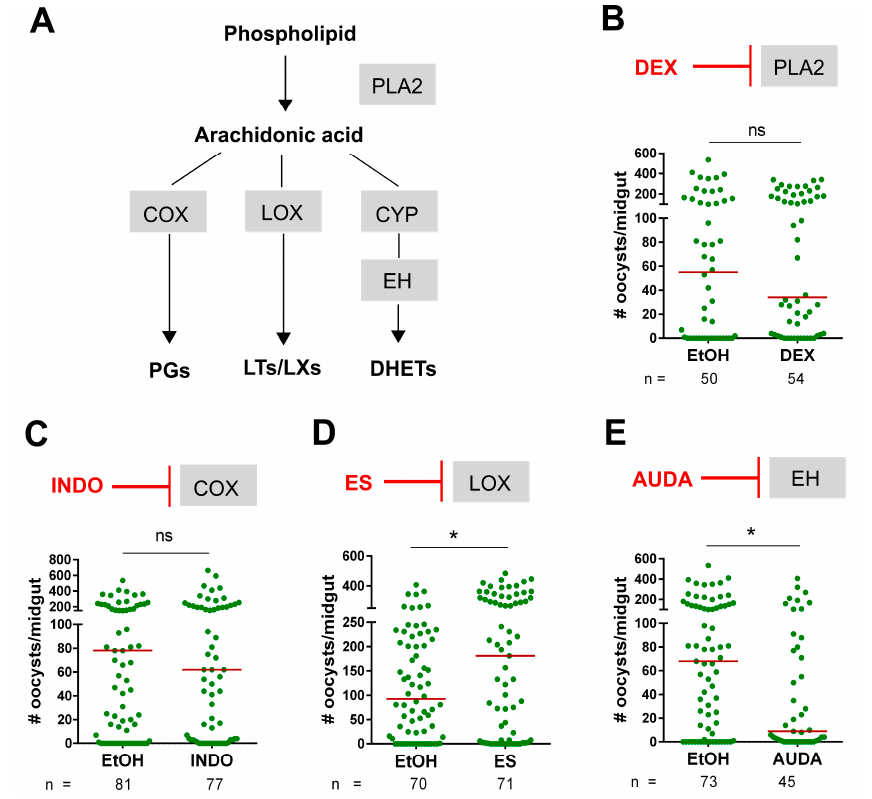
Figure 1. Effect of eicosanoid inhibitors on Plasmodium oocyst survival. Biosynthesis pathways of eicosanoids as described in mammalian systems are summarized in ( A ). Arachidonic acid (AA) is derived from membrane phospholipids by hydrolysis of phospholipase A2 (PLA2) activity. The AA is further metabolized into various eicosanoids, such as prostaglandins (PGs), leukotrienes (LTs), lipoxins (LXs) and dihydroxyeicosatrienoic acids (DHETs) through the activity of specific enzymes, cyclooxygenase (COX), lipoxygenase (LOX), cytochrome P450 (CYP), and epoxide hydrolase (EH), respectively. The influence of specific eicosanoid inhibitors on P. berghei survival was addressed in mosquitoes injected with each respective inhibitor by examining oocyst numbers at 8 days post- infection ( B – E ). Compared to an ethanol (EtOH) control, oocyst survival was examined for the PLA2 inhibitor, dexamethasone (DEX) (B), a COX inhibitor, indomethacin (INDO) (C), a LOX inhibitor, esculetin (ES) (D), and an epoxide hydrolase inhibitor, AUDA ( E ). Data were analyzed by Mann- Whitney U using GraphPad Prism 6.0. Bar graphs represent mean ± SEM of three independent experiments. Asterisks denote significance (* p < 0.05); ns, not significant. Since previous work has argued for the role of lipoxins in immune priming and innate immune function in An. gambiae [23], and genes orthologous to mammalian lipoxygenase (LOX) have not been found, we focused our attention on the DHET pathway. Using orthologous genes for epoxide two potential candidates in the An. gambiae genome: cytoplasmic epoxide hydrolase 2 (cEH2; AGAP003542) and epoxide hydrolase (EH; AGAP011972), of which EH function has previously been confirmed for the generation of epoxy fatty acids [36]. Thus, RNAi experiments targeting each gene were performed to determine their roles in Plasmodium survival. Both cEH and EH were effectively silenced following dsRNA injection as compared to GFP controls (Figures 2B and 2C), yet only EH- silencing significantly influenced oocyst numbers (Figures 2C), resulting in a similar phenotype to AUDA treatment (Figure 1E). This provides further support for the influence of DHETs on malaria parasite survival.